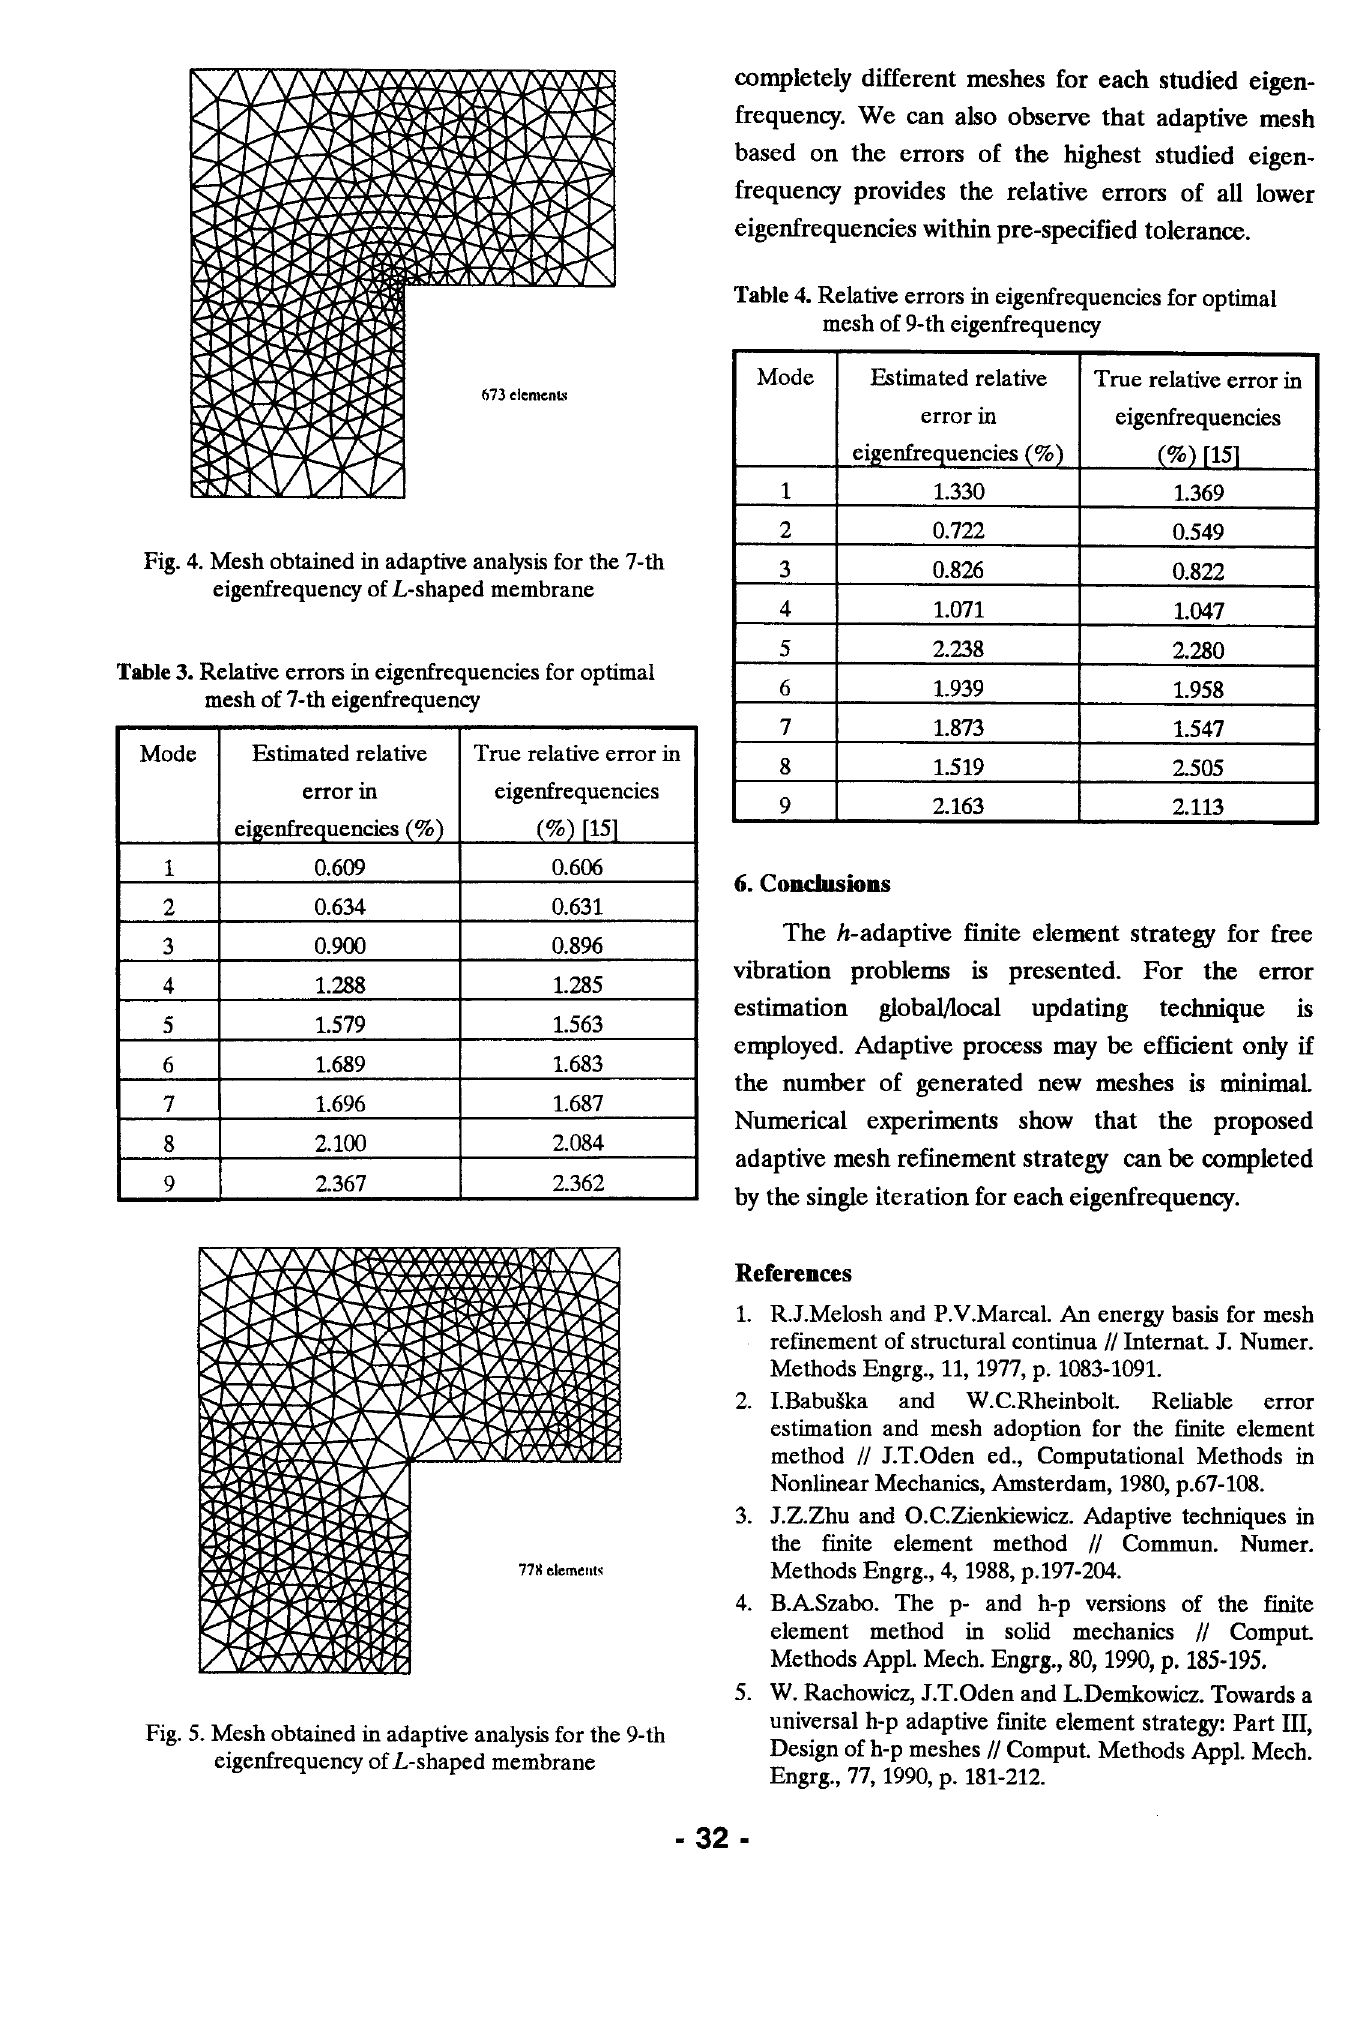
Fig. 5. Mesh obtained in adaptive analysis for the 9-th eigenfrequency of L-shaped membrane